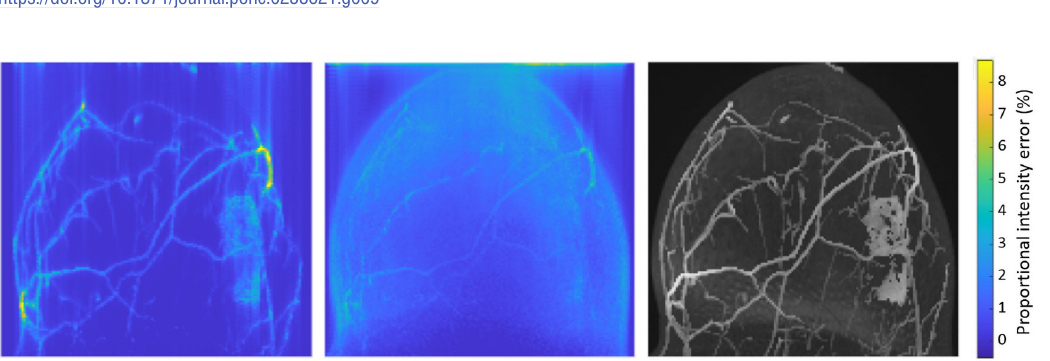
Fig 10. Proportional intensity error per voxel for case 4. Proportional intensity error is shown from the mean projection over time and through the volume. From left to right: IFFT reconstruction error, ECA reconstruction error, and the ground truth image.